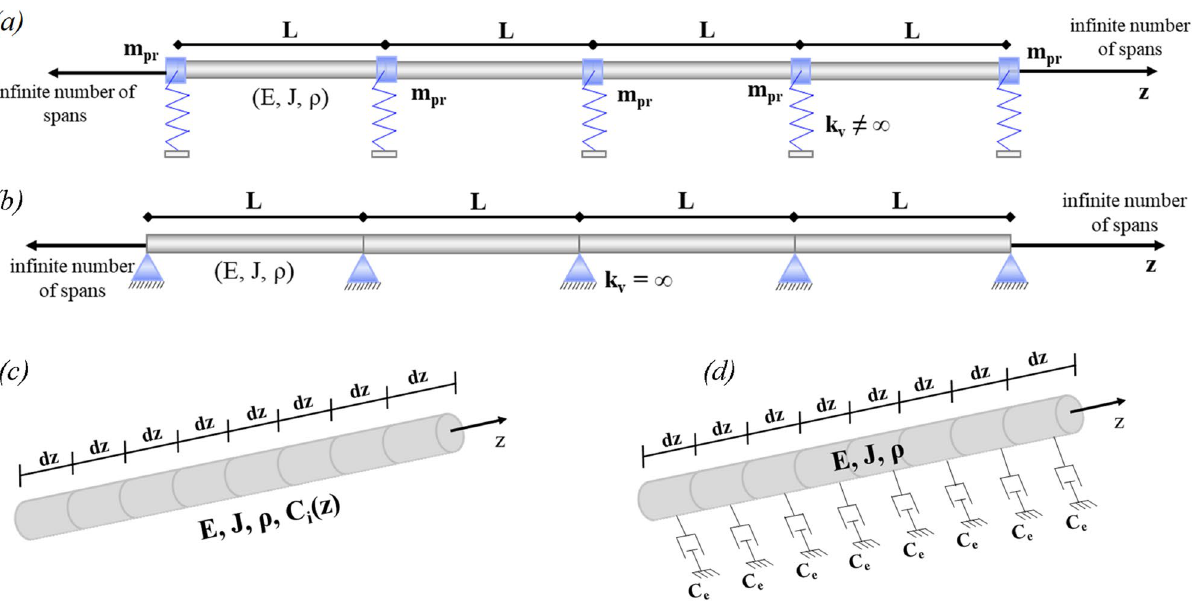
Figure 2. ( a ) PPR f : periodic damped pipeline coupled with the flexible supports and the masses m pr of a pipe rack; ( b ) PPR r : periodic damped pipeline on rigid supports; ( c ) internal or structural damping model for a continuous beam and ( d ) external viscous damping